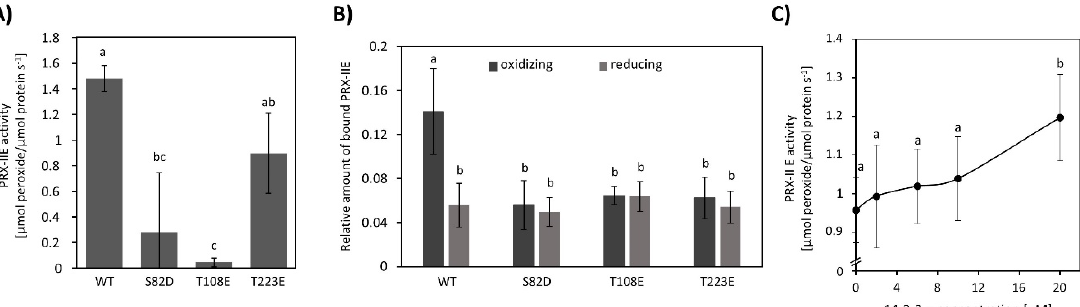
Figure 11. Influence of phospho-mimicry point-mutations on the activity of PRX-IIE and the interaction with 14-3-3 υ . ( A ) Peroxide reduction of WT PRX-IIE and its phospho-mimicry variants were measured with 400 µ M H 2 O 2 , 4 mM DTT, and 2 µ M protein. The decrease in H 2 O 2 was quantified using the FOX assay. Data are means of n = 10–16 ± SD with protein from three independent protein purifications. Different letters indicate groups of significant differences ( p ≤ 0.05) calculated by one-way ANOVA and post hoc Tukey HSD. ( B ) Overlay assay of 14-3-3 υ with PRX-IIE. A higher affinity of PRX-IIE to 14-3-3 υ was observed under oxidizing conditions. Data are means of n = 13–22 ± SD. Significant differences were calculated using one-way ANOVA with post hoc Tukey HSD and are indicated by different letters, whereas p ≤ 0.05. ( C ) Influence of 14-3-3 υ on the peroxidase activity of PRX-IIE. The activity of PRX-IIE was measured in the presence of different concentrations of 14-3-3 υ with FOX Assay. Data are means of n = 12–18 ± SD. Letter a and b indicate groups of significant differences of p ≤ 0.05 calculated by one-way ANOVA with post hoc Tukey HSD.